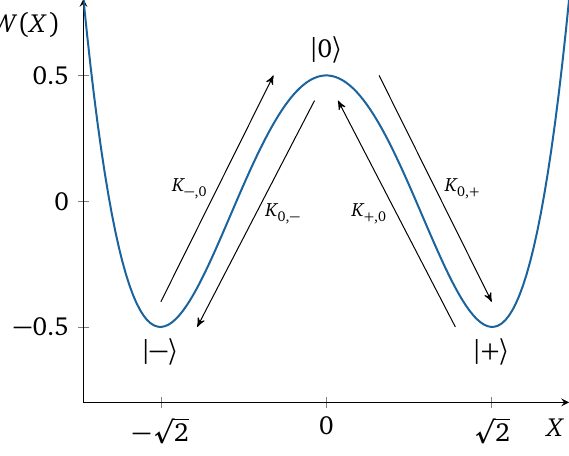
Figure 4: The three supersymmetric vacua and fundamental particles of the Chebyshev super- potential with k = 2. The fundamental kinks all have energy E = ∆ W = 1. The supercharges relate the kinks K to anti-kinks ¯ K , the latter are not depicted in the figure.